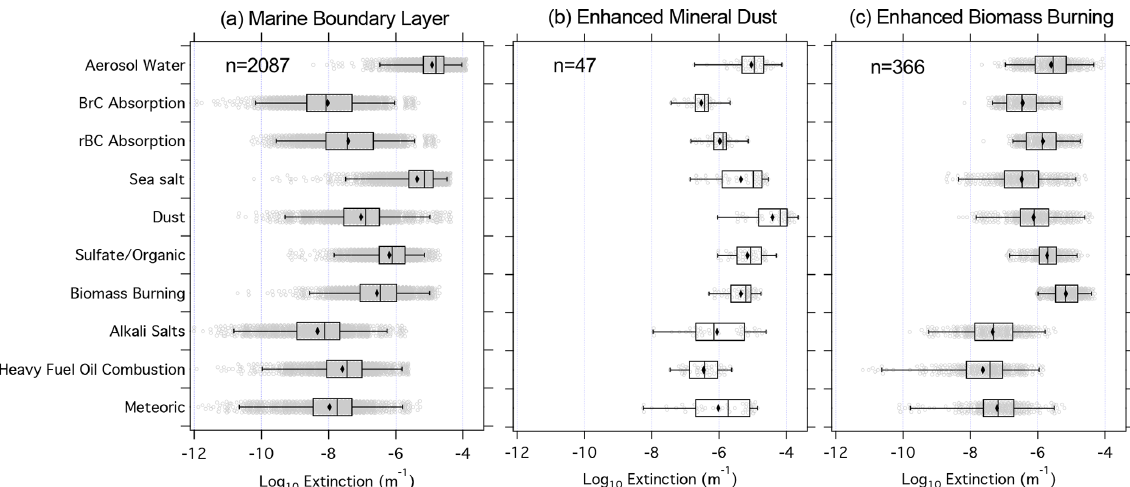
Figure 10. Contributions of different aerosol components to the logarithm of aerosol extinction (a) in the MBL, (b) in regions of enhanced mineral dust particle concentrations, and (c) in regions of enhanced biomass burning particle concentrations. Absorption only is shown for the BrC and rBC components. Each gray point is calculated from a single 60s measurement. Boxes indicate the interquartile range, the central line represents the median, the diamond symbol represents the mean of the logarithm, and the whiskers are at the 2nd and 98th percentiles. The number of 60s data points in each air mass type is